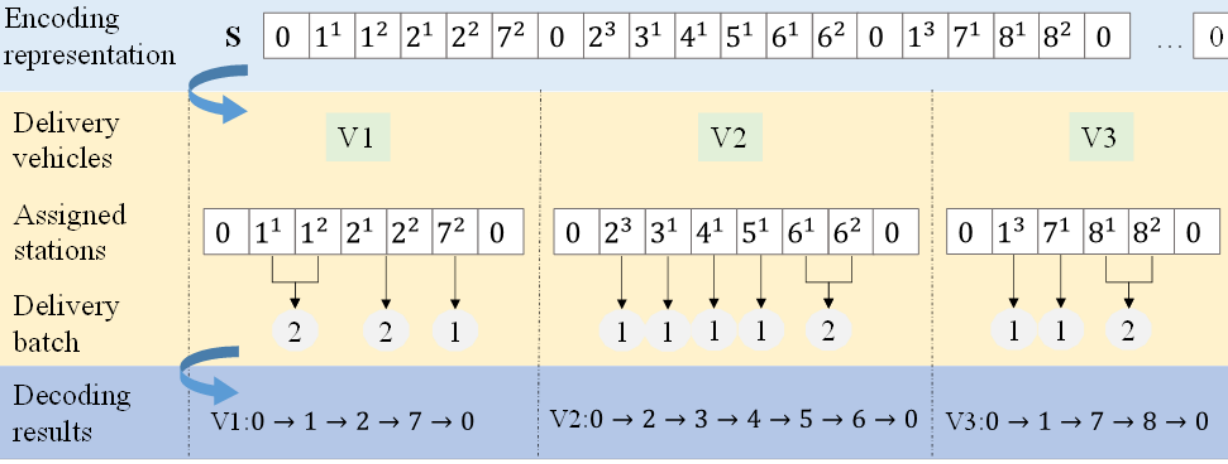
Figure 2. The graphical representation of the expression of solutions.